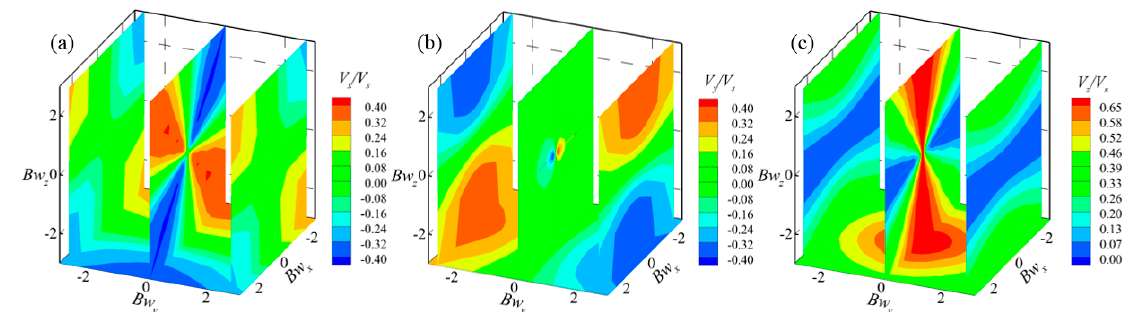
Figure 18. Swimming velocity, ( a ) V x / V s , ( b ) V y / V s , and ( c ) V z / V s with w x , w y , and w z .